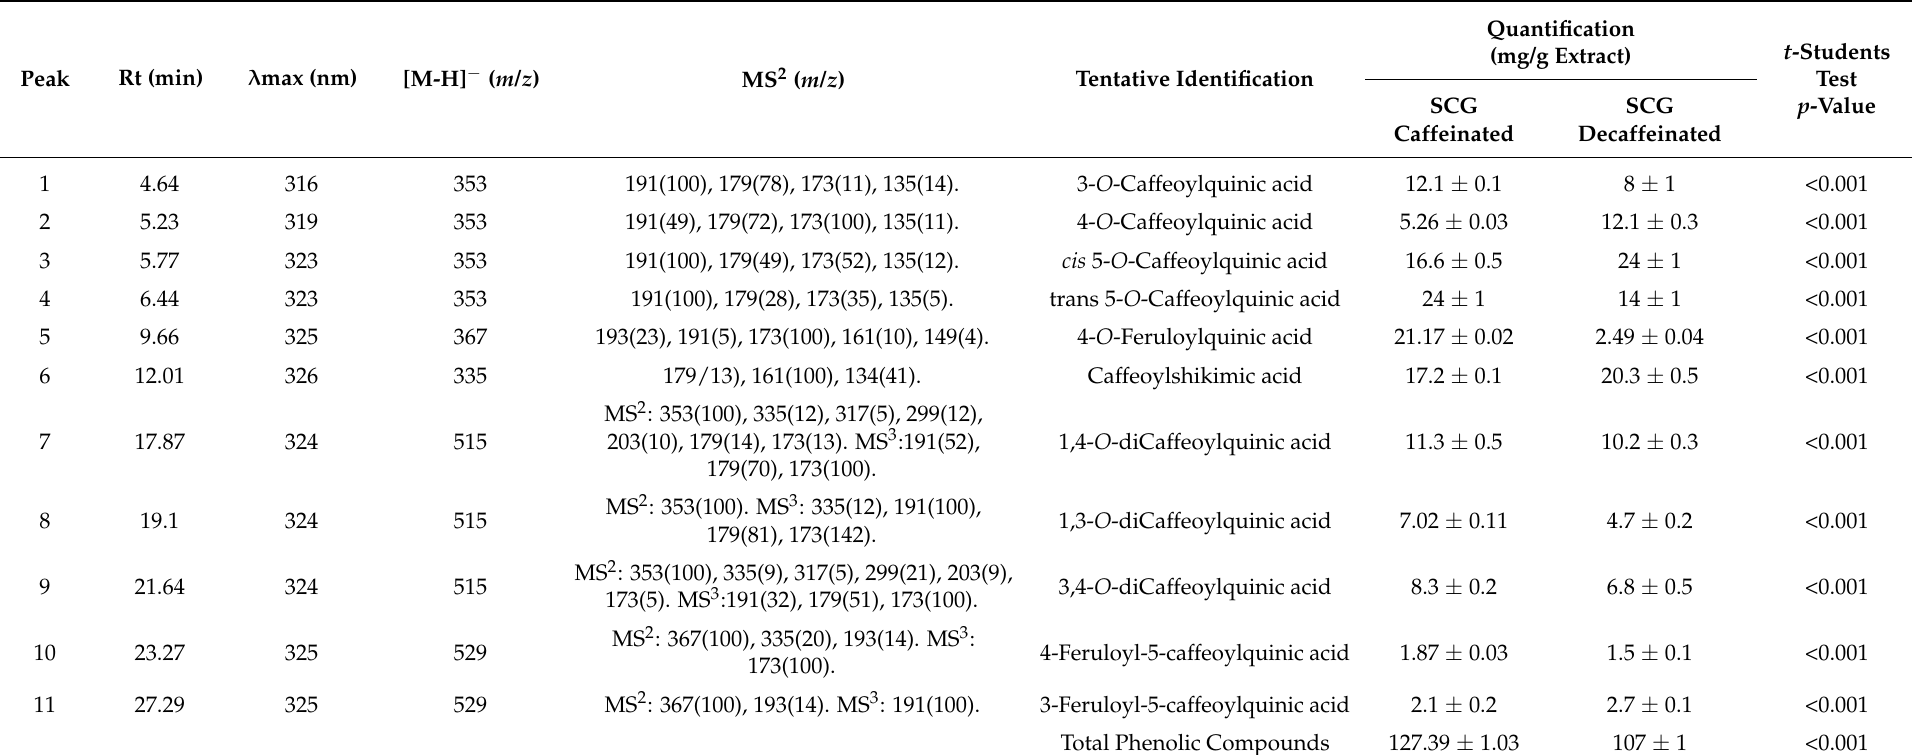
Table 1. Phenolic profile of caffeinated and decaffeinated SCG ethanol